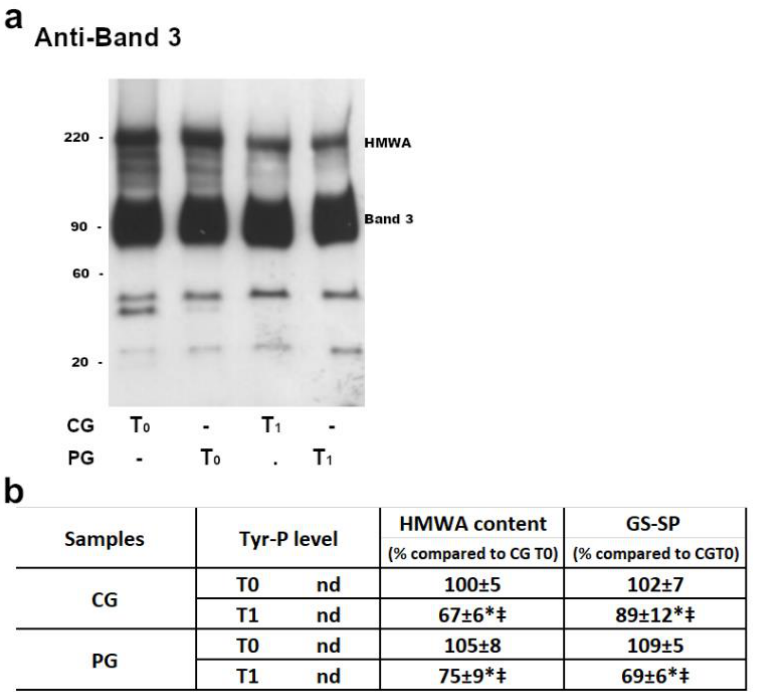
Figure 2. The membranes (10 µ g) obtained, as described in the Methods section, were analyzed by Western blotting in non-reducing conditions (panel a ) and immunostained with anti-band 3 P-Tyr antibodies or in non-reducing conditions and immunostained with anti-band 3 (panel a and b ), anti-P-Tyr or anti-GSH antibodies (panel b ). For each immunostaining, bands corresponding to the relative proteins were densitometrically estimated and statistically analyzed (panel b ). The Tyr-P value of both CG and PG RBCs were undetectable. The band 3 HMWA or GSH values were calculated as the ratio to band 3 HMWA or GSH obtained in basal (T 0 ) samples of CG (chosen as arbitrary comparison unit, experimentally determined as 100 ± 5% and 102 ± 7%, respectively). Data shows the means ± SD of n = 12 CG and n = 18 PG patients. Comparison from respective baseline values: * p < 0 .001, Student’s t -test for paired data. Comparison CG vs PG: ‡ p < 0 .001, Student t -test for unpaired data.